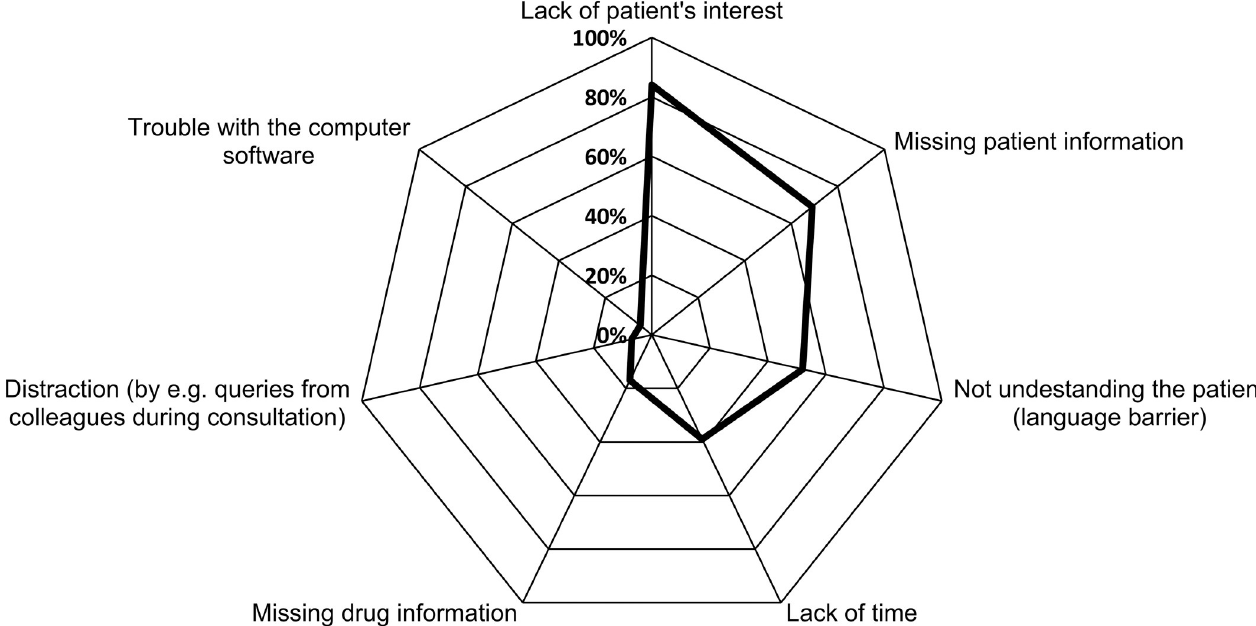
Fig 5. Pharmaceutical staff’s view of barriers to an appropriate counselling process. Answers to the question “Which of the following factors prevents you from providing an optimal patient consultation for self-medication?” [Multiple choice; N (total) = 1068].